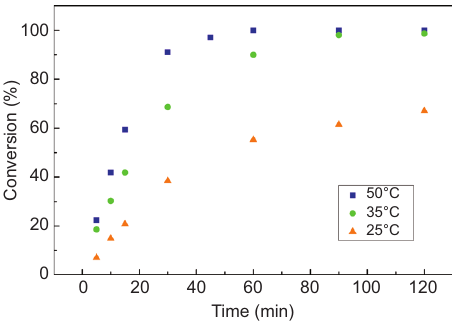
Figure 3 Temperature dependence of conversion with Pd NPs at atmospheric pressure of air in batch. Reaction conditions: 1